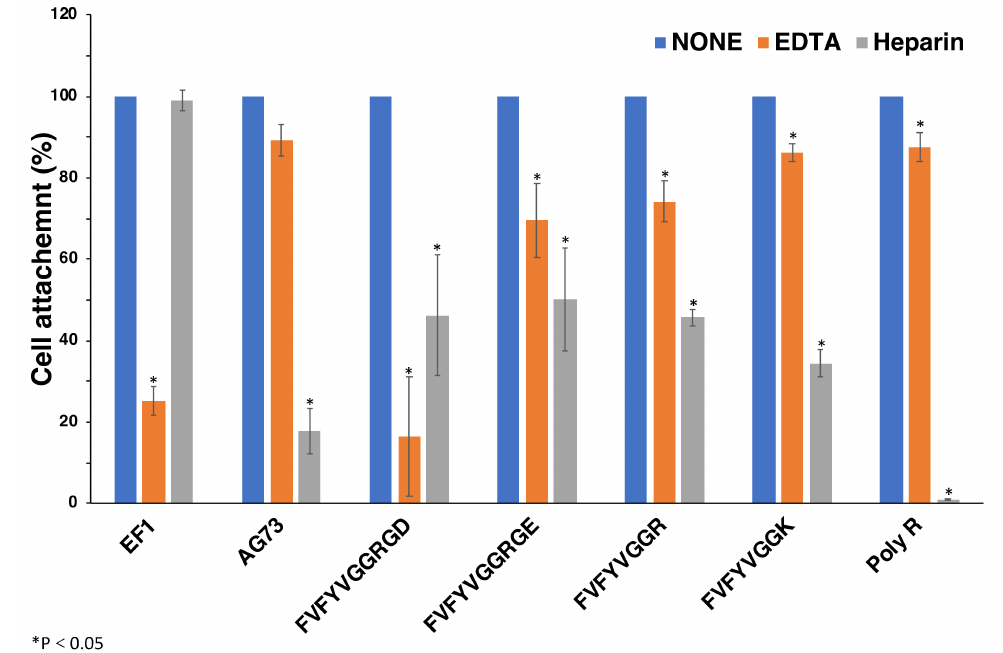
Figure 6. Effect of EDTA and heparin on cell attachment to the peptides. 96-well plate was coated with peptides (2 nmol/well of EF1, 0.4 nmol/well of AG73, 5 nmol/well of FVFYVGGRGD and FVFYVGGRGE, 10 nmol/well of FVFYVGGR and FVFYVGGK, 1 ng/well of poly R). HDFs were